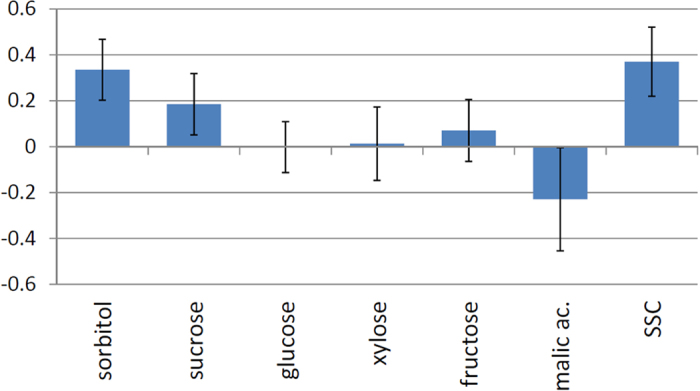
Coefficients of OPLS regression model for sweetness referring to scaled and centered data.Confidence intervals (95%) are derived from jack knifing.